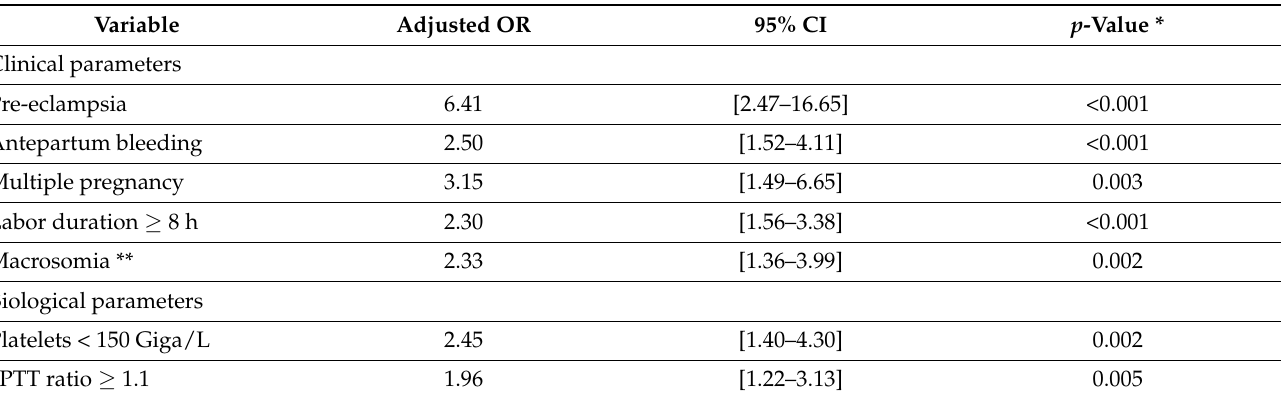
Table 2. Multivariable regression model.